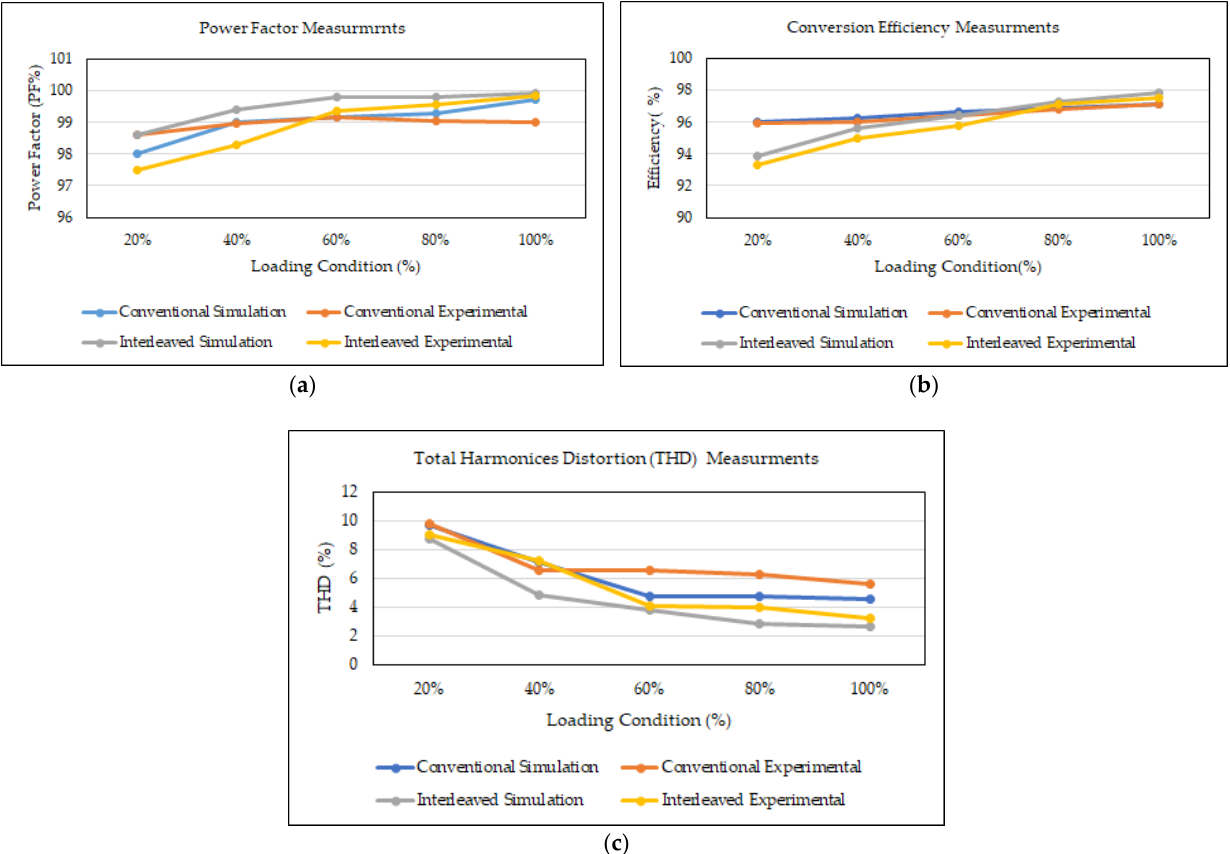
Figure 26. Performance measurements with different loading condition: ( a ) power factor (PF); ( b ) conversion efficiency; ( c ) THD (total harmonic distortions).